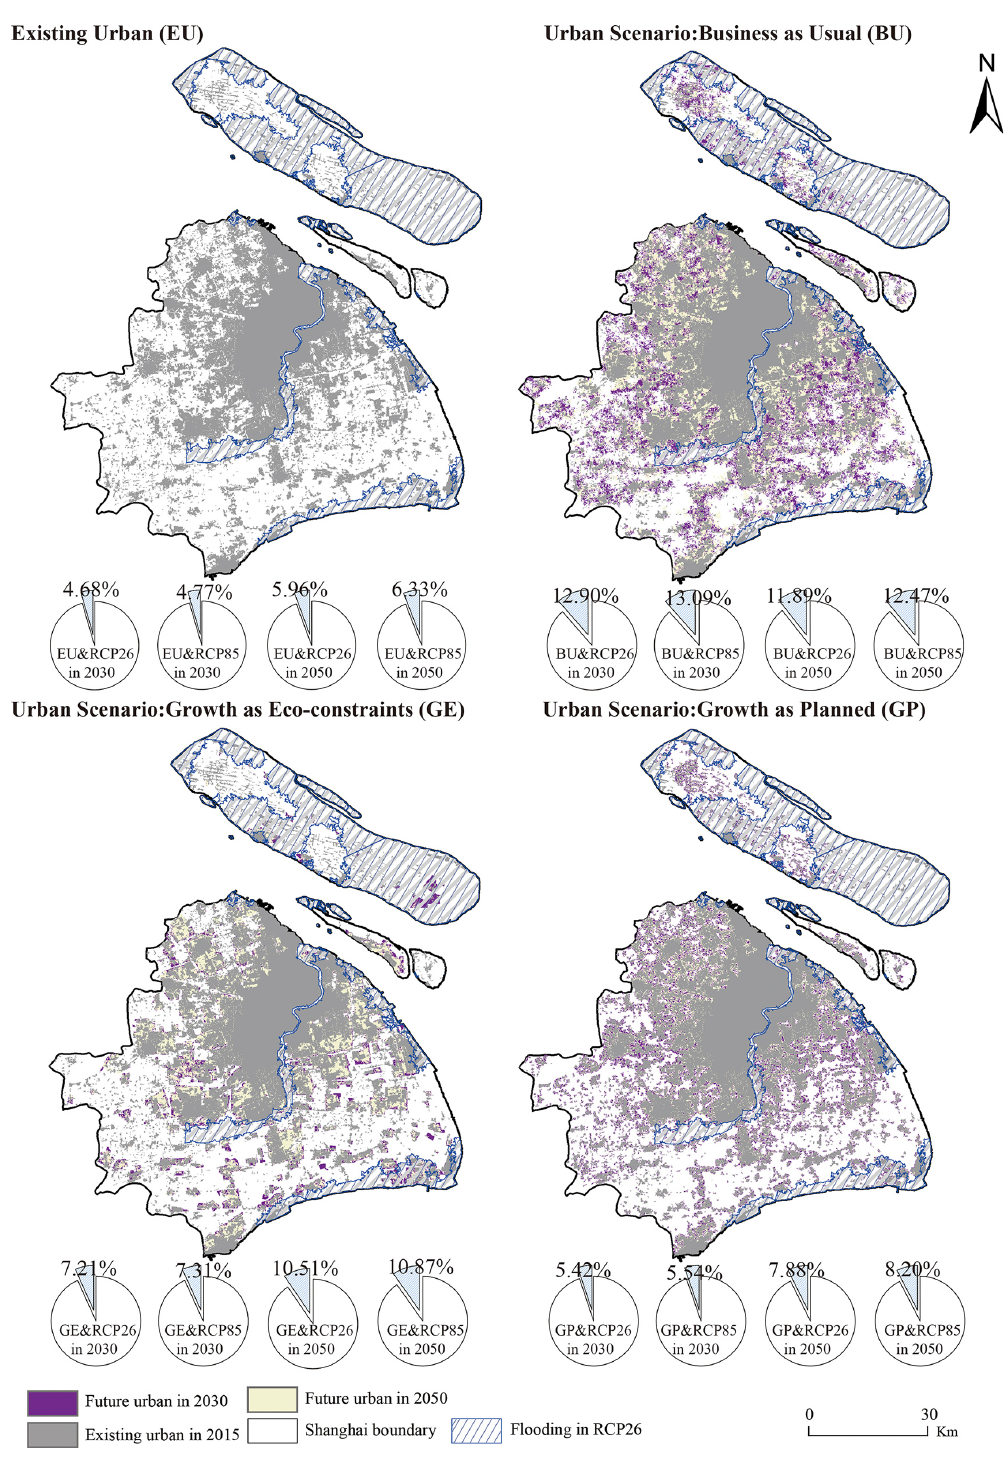
Figure 5. Flood exposure of existing urban and future urban growth scenarios. The four pie charts for the BU, GE and GP scenarios represent the proportion of new grown urban area exposed to flooding under the 2030 RCP2.6, 2030 RCP8.5, 2050 RCP2.6 and 2050 RCP8.5 scenarios. The four pie charts for the EU scenarios represent the proportion of the existing urban area affected by the future flood risk scenario.